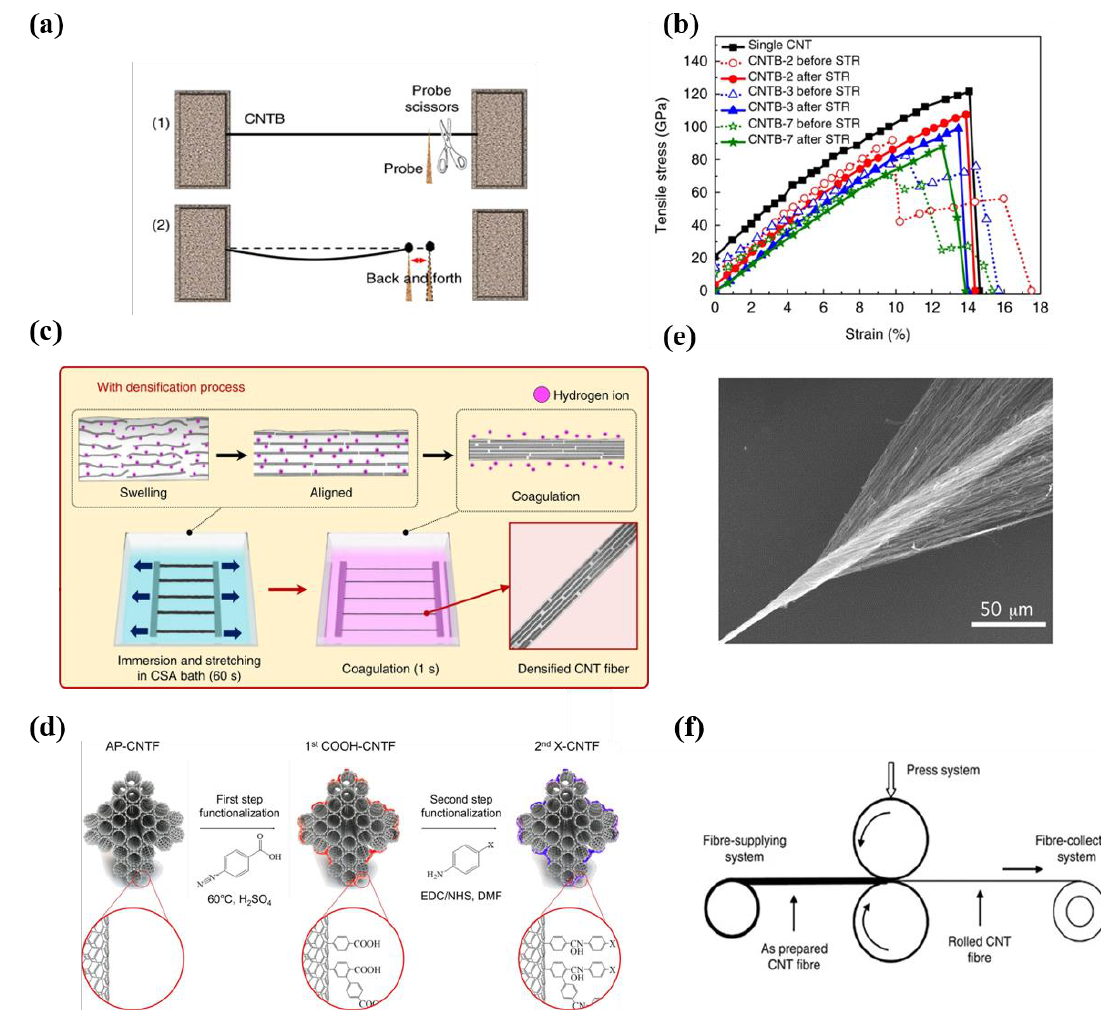
Figure 6. ( a ) Schematic diagram to make the initial stress of each tube more uniform. ( b ) Stress– strain curves for a single CNT and for CNTBs before and after the stress uniformity treatment. ( a , b ) Reproduced with permission from [10]. Copyright 2018, Springer Nature. ( c ) Schematic of the stretching and densification of CNTFs. Reproduced with permission from [6]. Copyright 2019,